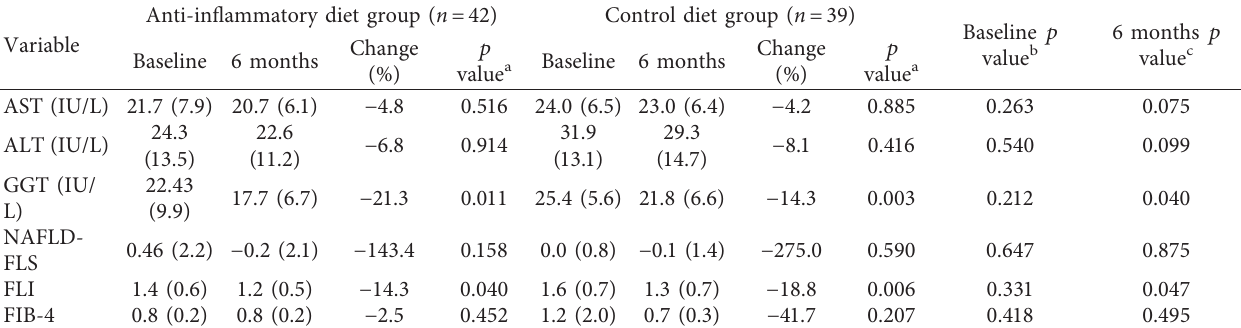
Table 2: Liver parameters at baseline and after 6months of dietary